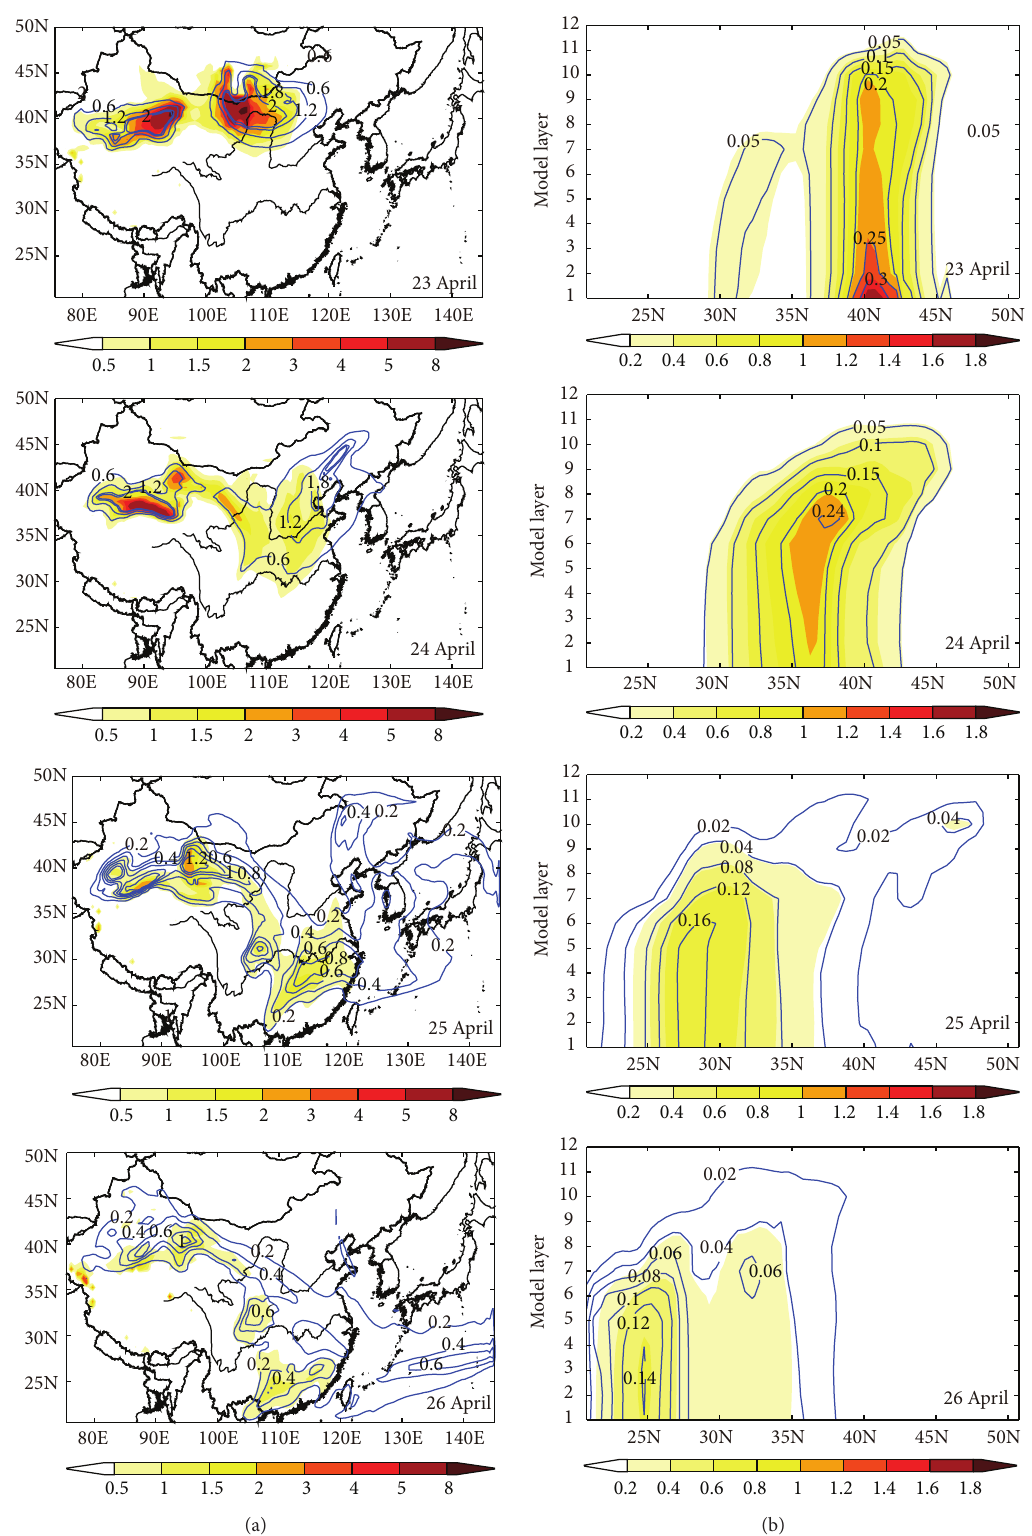
Figure 5: Daily mean (a) surface dust concentration (mg/m 3 ) and dust-induced AOD (blue contours with numbers) and (b) sectional average over 105 ∘ –125 ∘ E of dust concentration (mg/m 3 ) and dust extinction coefficient (km −1 , blue contours with numbers) for the dust storm period (23–26 April) from model